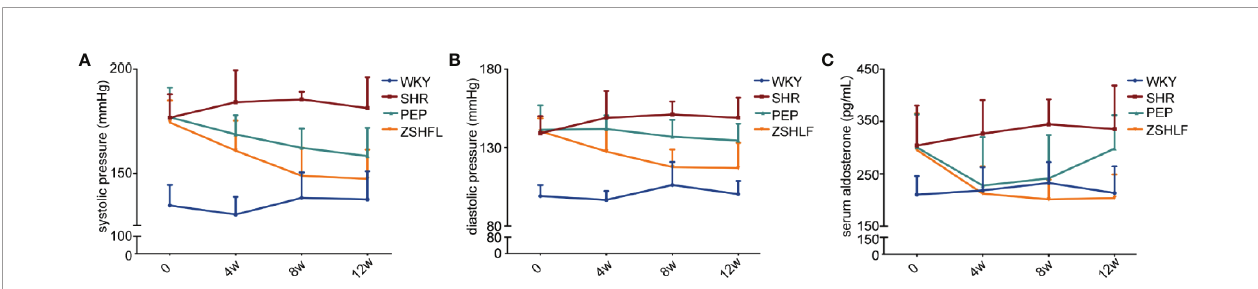
FIGURE 2 | Effect of Zi Shen Huo Luo Formula (ZSHLF) on blood pressure and serum aldosterone (ALD) levels in spontaneously hypertensive rat (SHRs). (A) Effect of ZSHLF on systolic pressure of rats in different groups at each time point. (B) Effect of ZSHLF on diastolic pressure in different groups at each time point. (C) Effect of ZSHLF on serum ALD levels in different groups at each time point. The data represent the mean ± standard deviation, n =